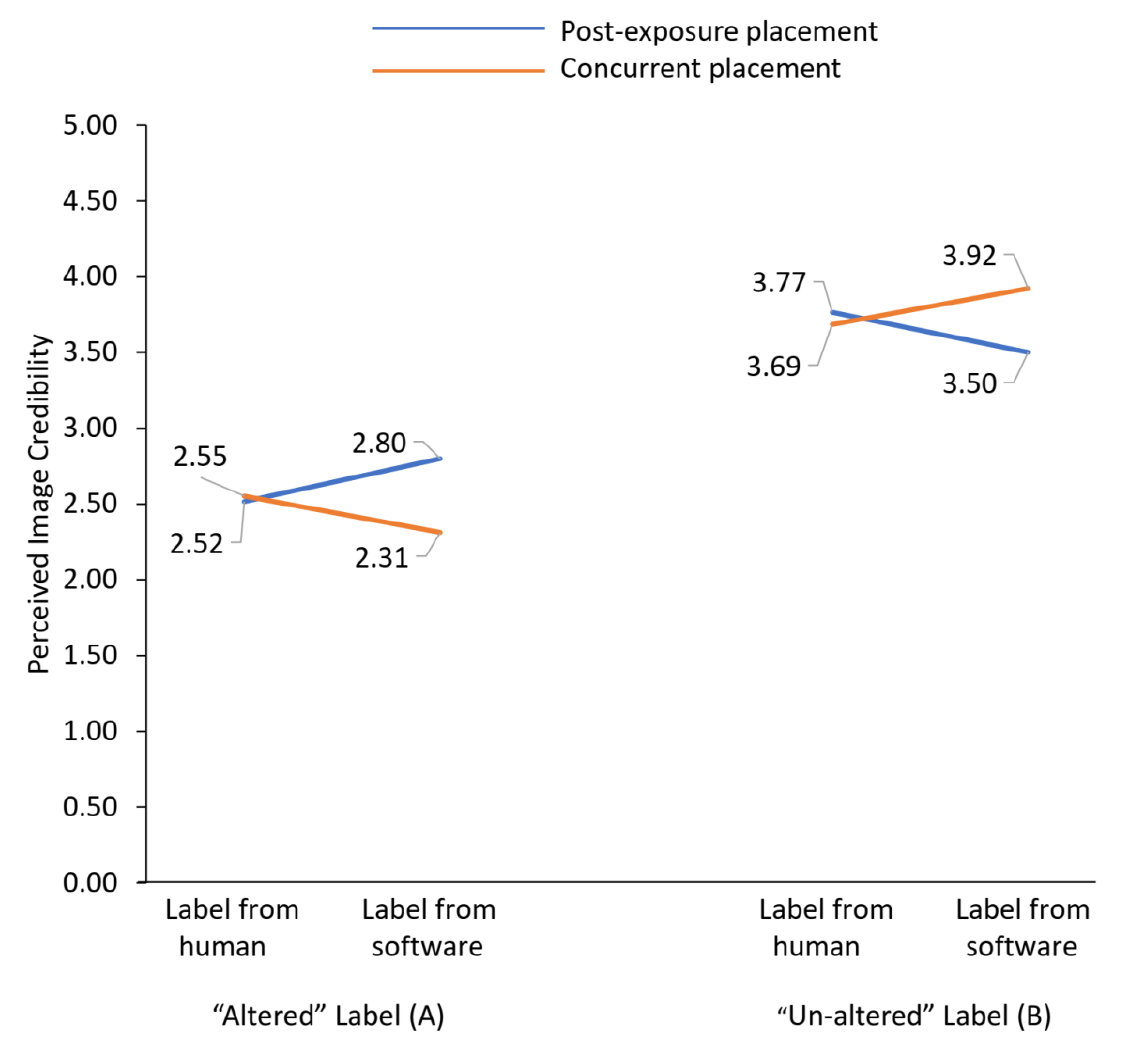
Figure 4. Significant interactions between forensic label placement and source of forensic label. Higher numbers represent greater perceived image credibility. Panel (A) shows the participants exposed to the “Altered” label, and Panel (B) shows those exposed to the “Un - altered” label. The “Human” condition combines “Experts'' and “Other people online” conditions (see